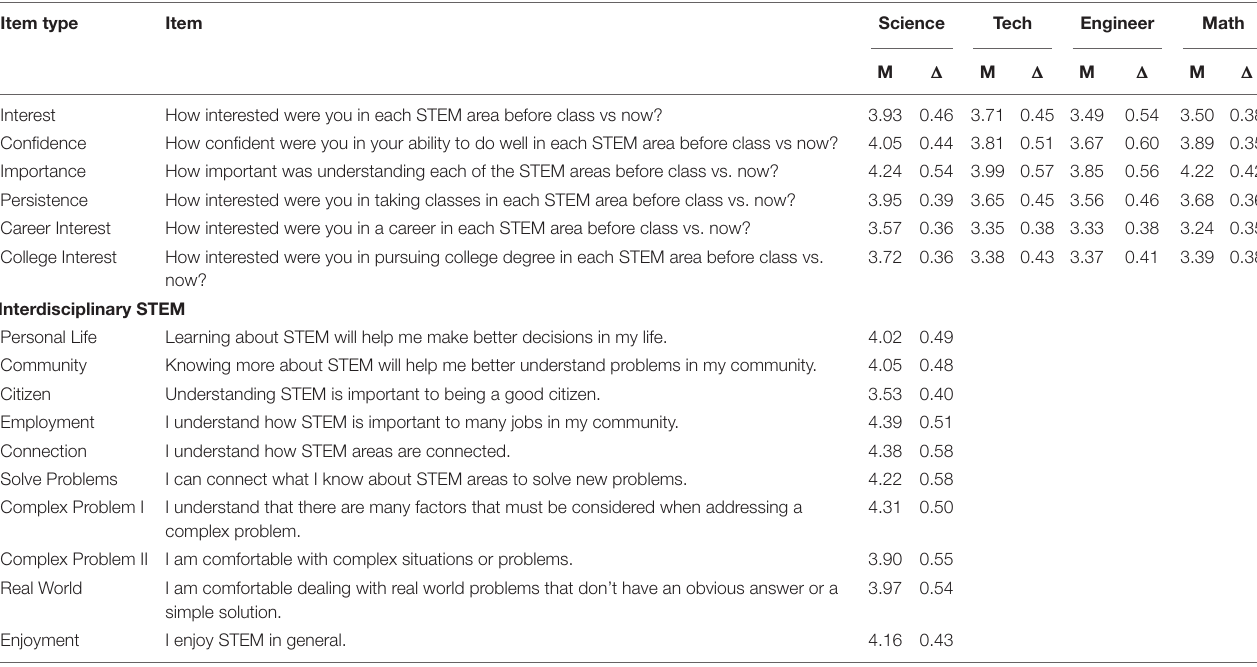
TABLE 1 | STEM student attitude survey.